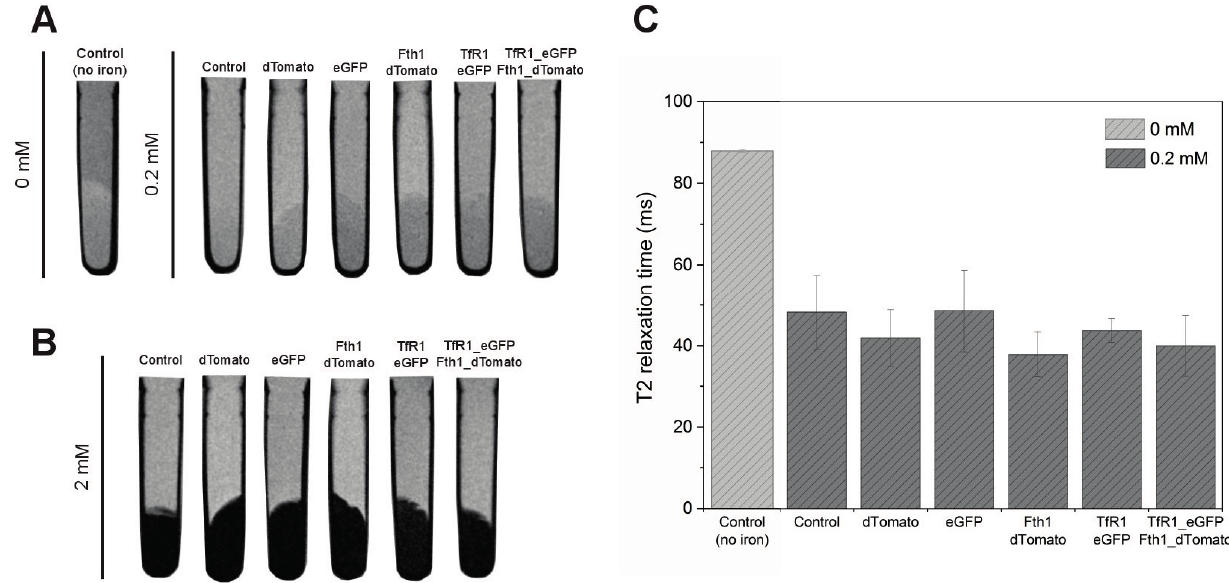
Figure 5. The effect of reporter genes on intracellular iron content of MSCs. Control and transduced cells were supplemented with ( A ) 0.2 mM ferric citrate from 24 h post transduction or ( B ) with 2 mM for 96 h prior to measurement. A control without iron supplementation is also shown. Error bars represent SEM ( n = 3). Asterisk denotes p < 0.05.